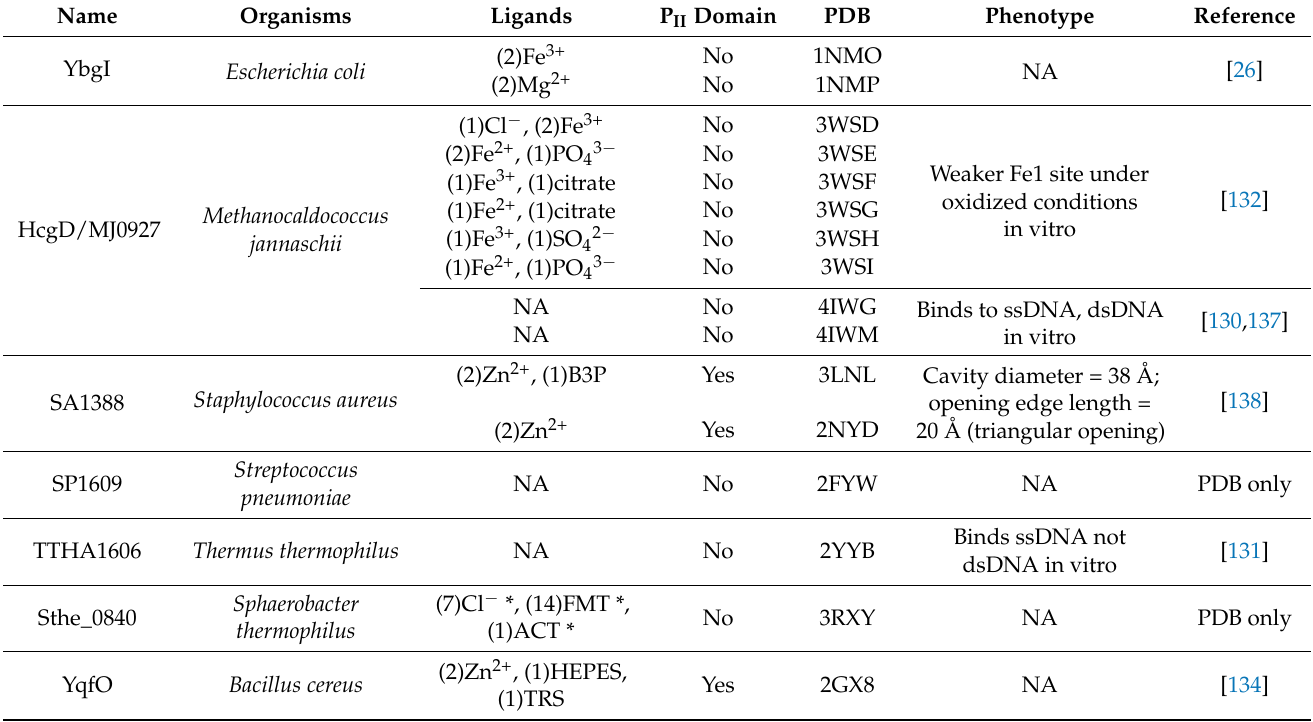
Table 2. Published structures of DUF34 protein family